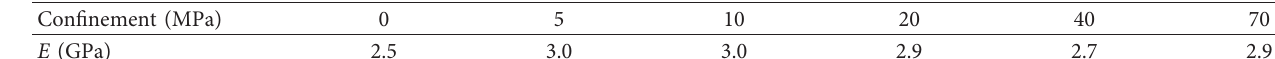
Figure 5: Failure modes of the PVC pipes. (a) p � 0 MPa and (b) p � 70MPa. Table 2: Elastic modulus of the PVC pipes.